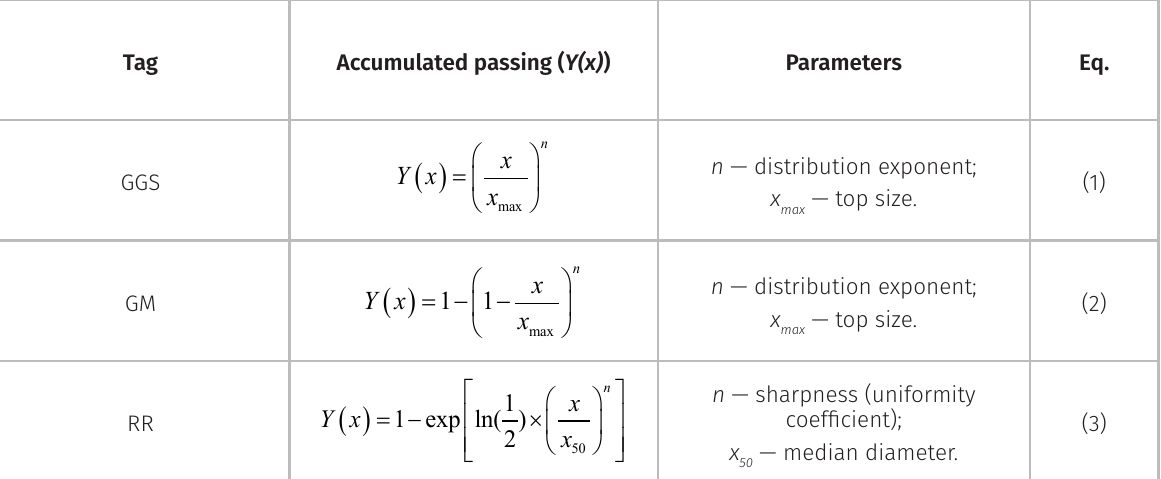
Table I. Usual distributions for characterization of polydisperse systems (real argument x is particle size).